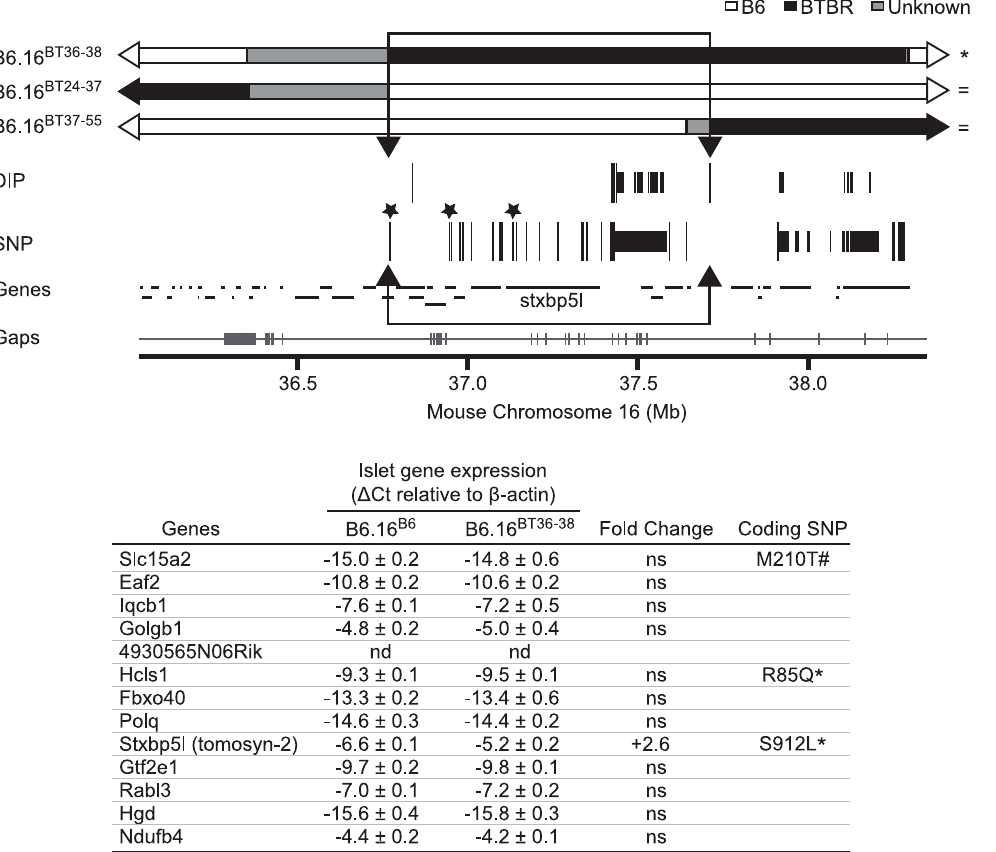
Figure 6. Insulin secretion defective region narrowed to 0.94 Mb on mouse chromosome 16 containing 13 genes. (A) Results from Agilent SureSelect Target Enrichment of a 35.35 to 38.65 Mb region on mouse chromosome 16 followed by Next Generation Sequencing. Listed are single nucleotide polymorphisms (SNP) and deletion insertion polymorphisms (DIP) between B6 and BTBR (listed in Dataset S2). Top: congenic maps (with respective B6, BTBR, and unknown domains – boundaries were determined via SNP/DIP sequencing analysis listed in Dataset S1) of the strains used to further define the region linked to the insulin secretion defect. Strains are listed as defective (*) or normal for insulin secretion (=). Those SNPs and DIPs subjected to additional confirmation are represented as longer lines. Non-synonymous coding SNPs are highlighted with asterisks. The boundaries of the inferred QTL region were defined by 1) the phenotypes of the sub-congenic strains and 2) sequencing of the region. We were able to exclude the grey region common to B6.16 BT36–38 and B6.16 BT24–37 because 1) the latter strain is phenotypically like B6 and the former strain is phenotypically like BTBR and 2) sequencing showed that the region is identical by descent between B6 and BTBR. Bottom: genes located in this region as well as the breadth of the sequence coverage area (with gaps shown as tick marks along the line) (Gaps are listed in Dataset S4). The 0.94 Mb region containing the locus for defective insulin secretion is represented as an open box with arrowheads. B) Genes in the 0.94 Mb region with their measured islet gene expression, fold change, and presence of non-synonymous coding SNPs. Not determined (nd), not significant (ns), *